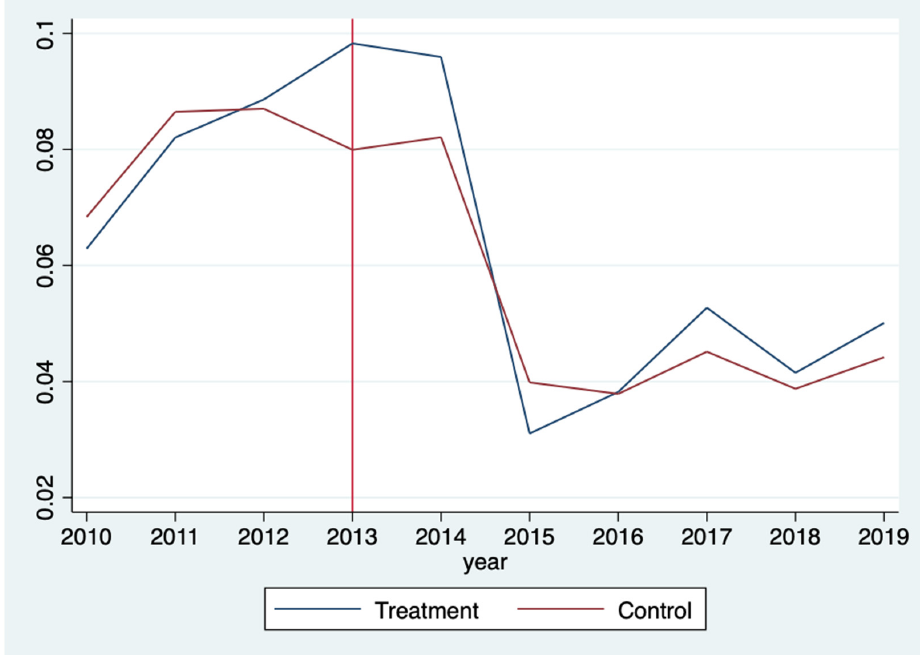
Figure 3. Propensity to Purchase Non-Major Appliances. Source: Author’s own construction.